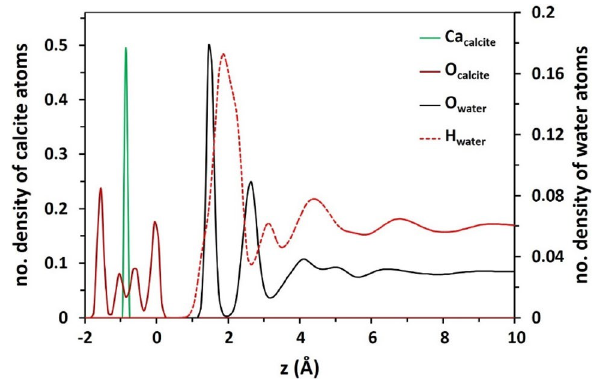
Figure 1. The density profile of water atoms with respect to Ca and O-atoms of the topmost calcite layer. These densities are almost identical in all salinities. The origin of the distance to surface measurements is based on the outermost O-atoms of